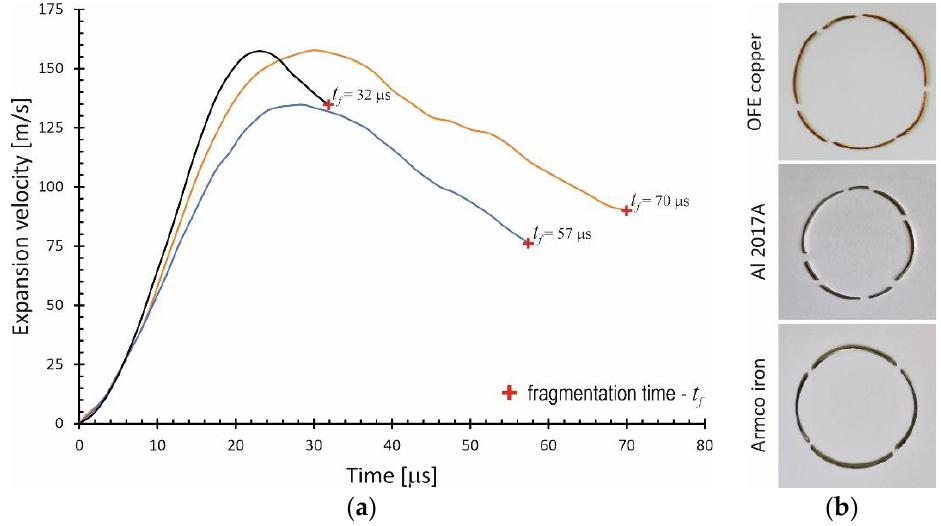
Figure 3. ( a ) Representative expansion velocity curves obtained from ring experiments performed for the OFE copper, 2017A aluminum alloy, and Armco iron; ( b ) view of recovered fragments generated from different sorts of material rings.